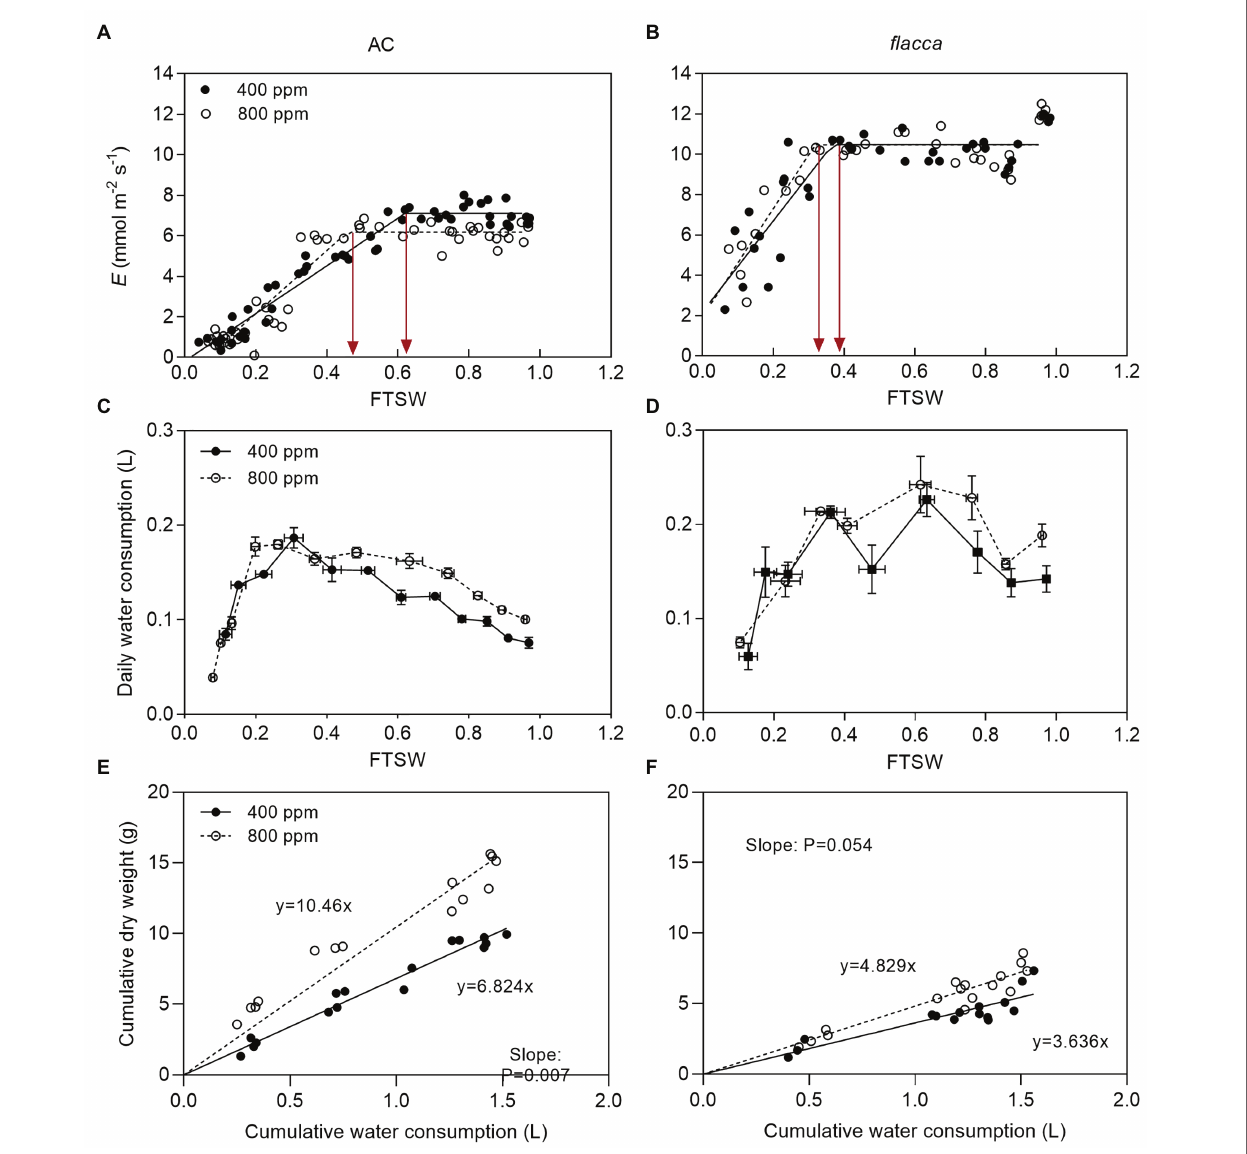
FIGURE 1 | (A,B) changes of transpiration rate ( E ) of AC (total samples = 48, N = 4) and flacca (total samples = 32, N = 4) grown under ambient (400 ppm) and elevated (800 ppm) atmospheric CO 2 concentrations during progressive soil drying. FTSW represents the fraction of transpirable soil water. Red lines represent FTSW thresholds, where E started to decline. (C,D) changes of daily water consumption of AC and flacca during progressive soil drying. Error bars indicate standard error of the means (S.E.; N = 3–4). (E,F) linear relationship between cumulative water consumption and dry weight of AC, and flacca during progressive soil drying. The slopes of the regression indicated plant water use efficiency (WUE plant ). Closed circles indicate plants under 400 ppm CO 2 concentration, and open circles indicate plants under 800 ppm CO 2